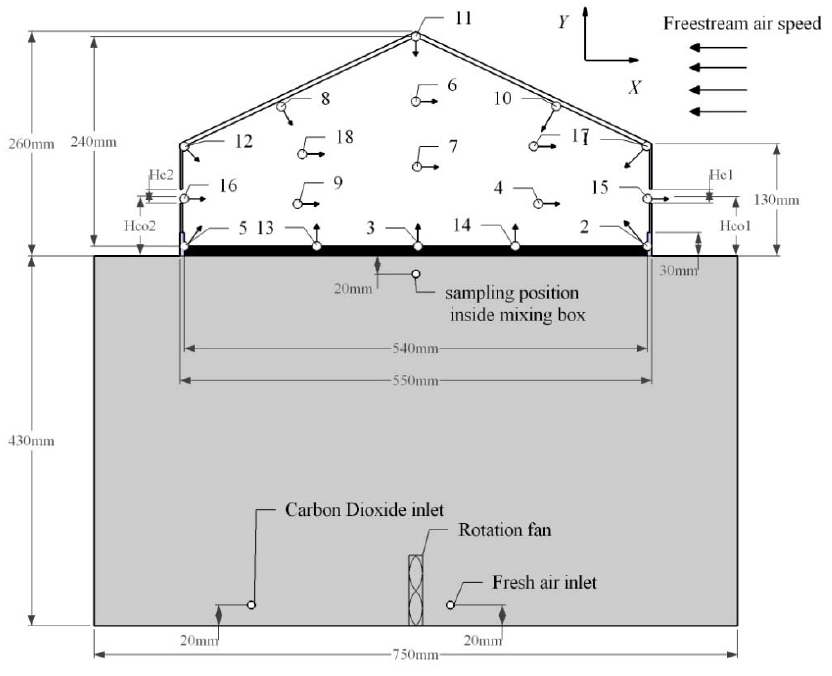
Figure 1. ( a ) Layout of sampling positions for measuring the indoor tracer gas concentration at the cross-section plane of the scaled building. ( ○ ) represent the sampling positions and 1–18 are labels of the positions, and the arrows indicate the direction of sampling’s opening against the airflow in the room. X,Y is the coordinate of the plane and the origin point lies in the middle of the floor. Hc leeward opening size, respectively; Hco windward and leeward opening to the floor, respectively. ( b ) Connection of sampling pipes in wind